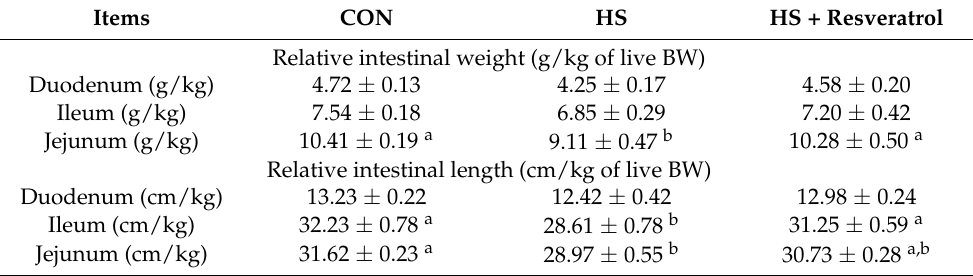
Table 4. Effect of resveratrol on intestinal characteristics of broilers under HS.